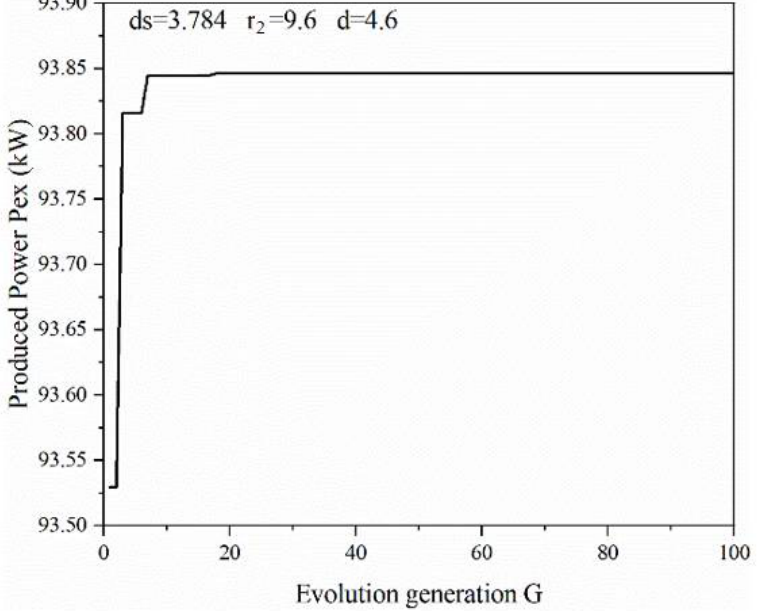
Figure 10. Variation of power with evolutionary generation G in the optimization process of the DE algorithm.